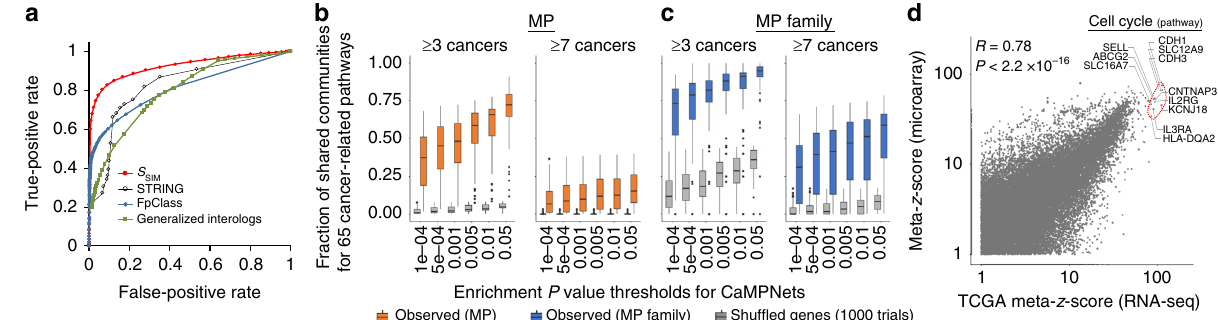
Fig. 2 Quanti fi cation of systematically integrated method (SIM) and MPP (an MP with binding partners) community-regulated pathways in 15 cancer types. a Receiver operator characteristic curves of the prediction accuracy of our integrated scoring ( S SIM ) method (red), STRING (black), FpClass (blue), and generalized interologs (green). b Analysis of the signi fi cance of community-regulated pathways shared by at least three (left) and seven (right) cancers across six enrichment P value thresholds. Among 65 cancer-related pathways, MPP communities were signi fi cantly more likely to be involved in a speci fi c pathway in distinct tumor types than was expected by 1000 random trials ( P < 4 × 10 − 10 , Wilcoxon signed-rank test). The box represents the interquartile range (IQR) and the horizontal line in the box is the median. The whiskers denote the lowest and highest values within 1.5 times IQR from the fi rst and third quartiles, respectively. The black dots represent outliers. c Signi fi cance analysis of communities in 197 MP families (blue) for certain pathways shared by multiple cancers ( ≥ 3 or 7 types) across different thresholds of enrichment P values (for details, see Supplementary Figs. 14b and 15). d Meta- z -scores between The Cancer Genome Atlas RNA-seq data ( n = 5922 tumors) and 15 independent microarray sets ( n = 528 tumors) showing a high correlation ( R = 0.78, P < 2.2 × 10 − 16 , Pearson test). Meta- z -scores depict the statistical signi fi cance of associations between MPP communities and certain pathways across 15 cancers. Source data are provided as a Source Data fi